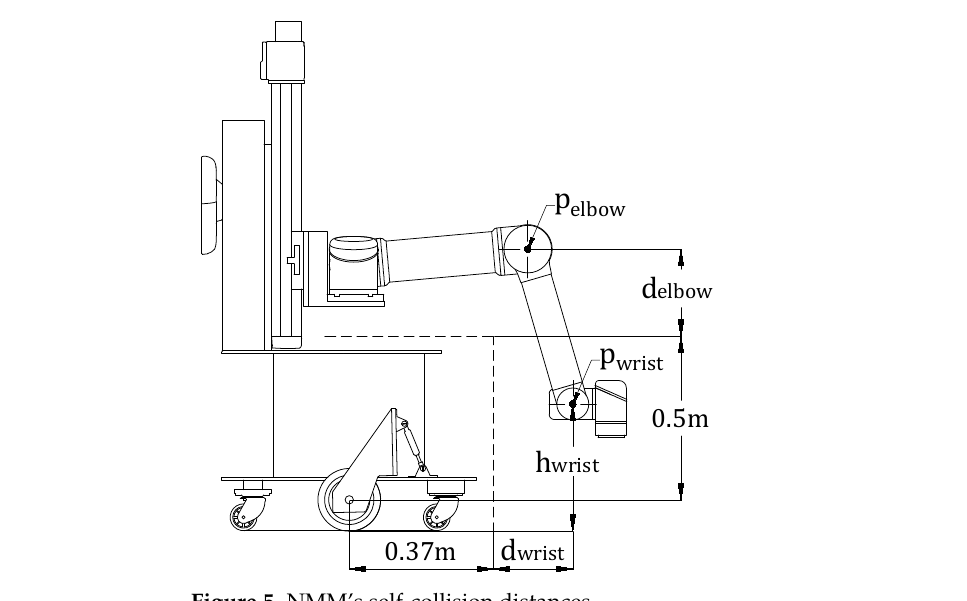
Figure 5. NMM’s self-collision